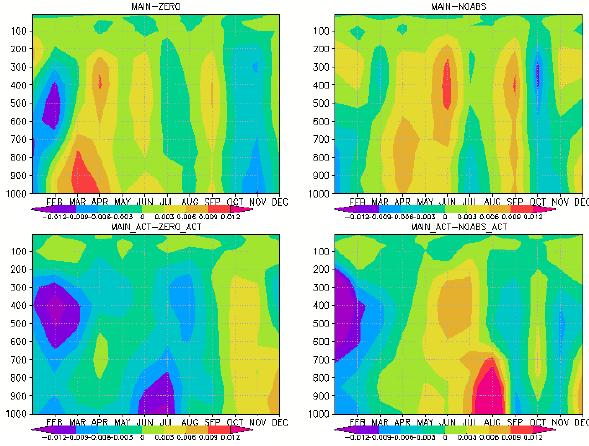
Figure 12. Vertical velocity anomalies averaged over the longitude– latitude box 65–90 ◦ E, 5–35 ◦ N ( − Pas − 1 ) at different pressure lev- els in the different simulations, 7-year monthly